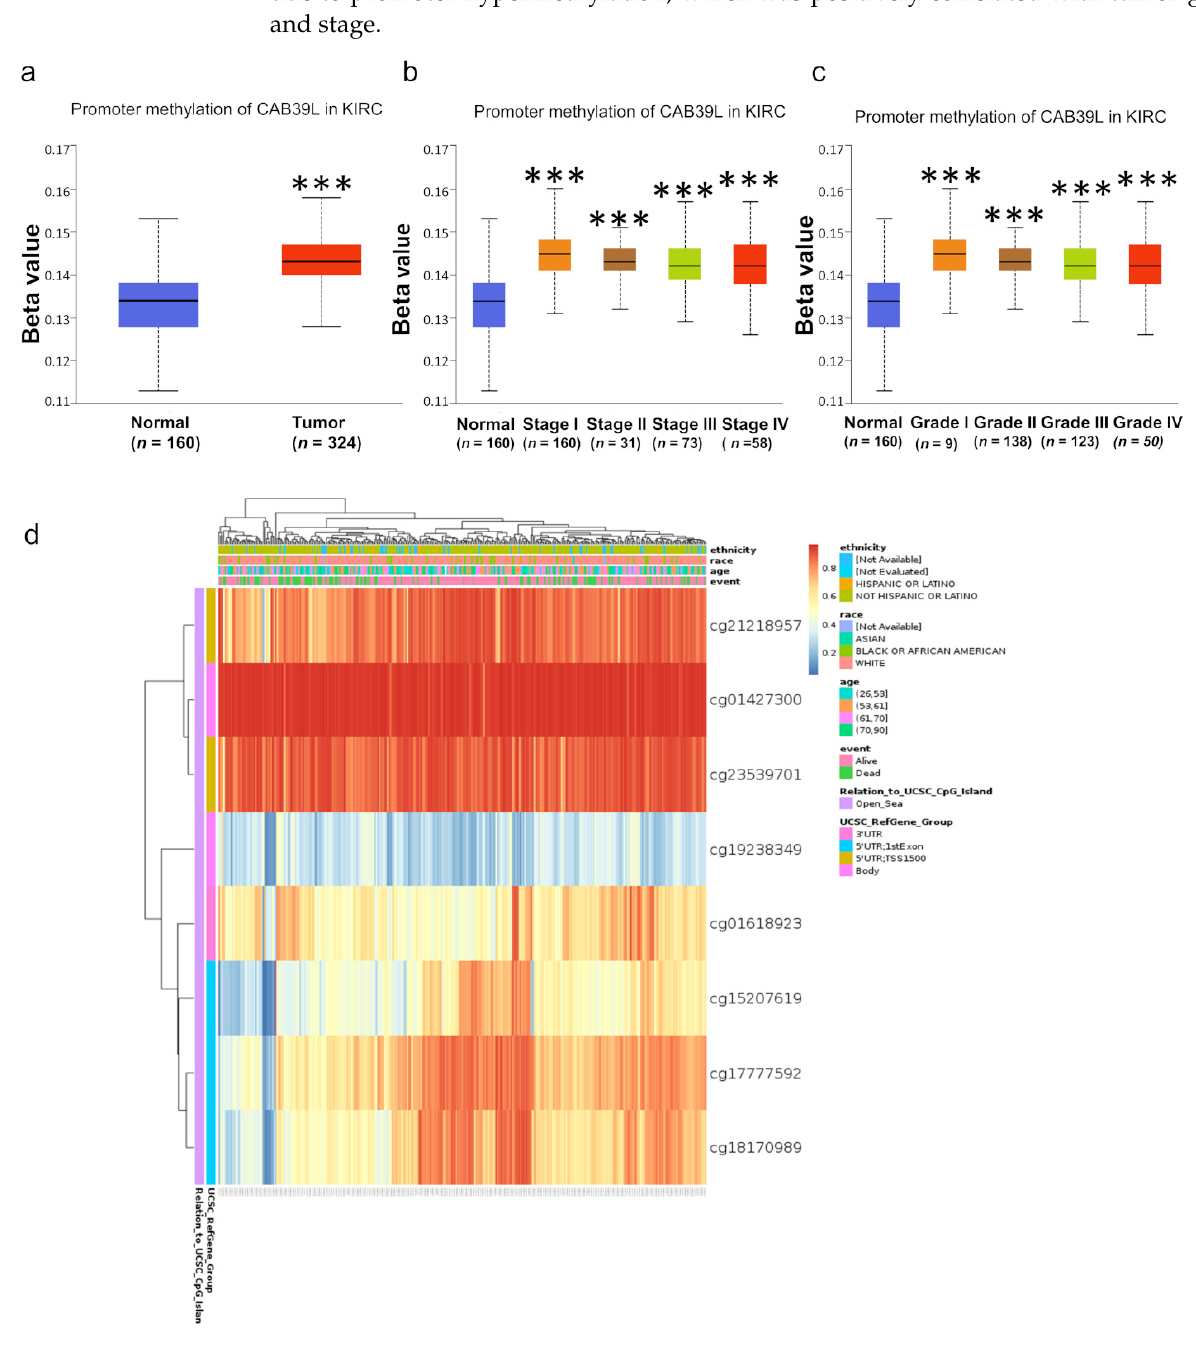
Figure 8. Analysis of methylation level in the CAB39L gene promoter region. ( a ) Analysis of methylation level of the CAB39L gene promoter region for KIRC compared with normal tissues (UALCAN). ( b , c ) Analysis of the relationship between methylation level of the CAB39L promoter region and pathologic stages (UALCAN). ( c ) Analysis of the relationship between methylation level of the CAB39L promoter region and histologic grades (UALCAN). ( d ) Analysis of methylation level of the CAB39L promoter region at CpG sites (MethSurv). *** p < 0.001.